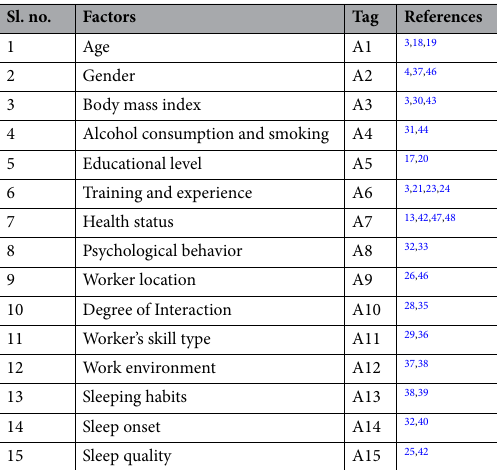
Table 1. Factors affecting worker productivity in the construction industry. Source: Authors’ Compilation, 2023.